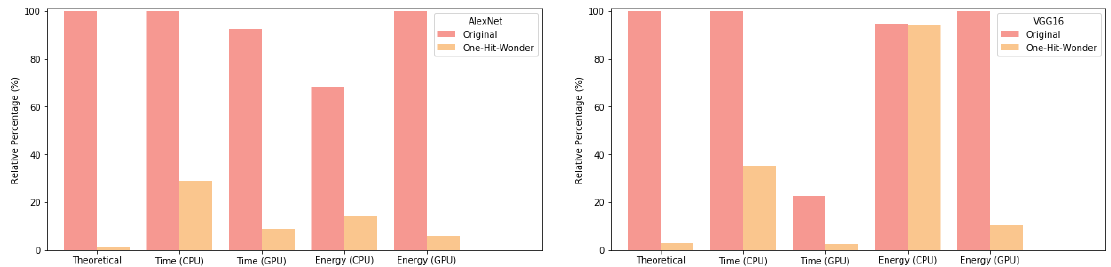
Figure 5. Comparison of layers between original and pruned version of both AlexNet and VGG16 on the NWPU-RESISC45 dataset.